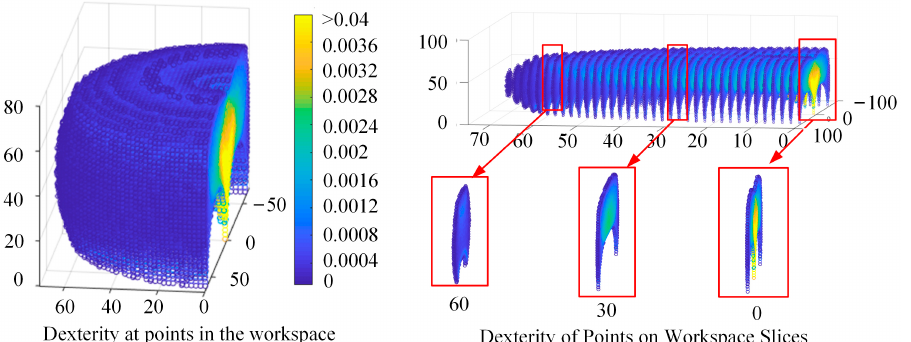
Figure 12. The dexterity performance of the CTR.